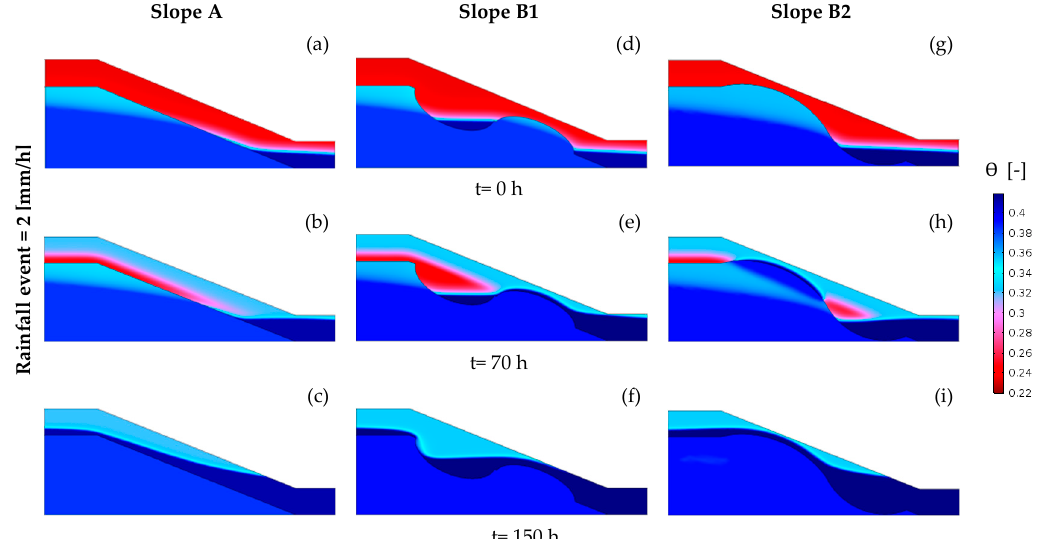
Figure 9. The temporal development of the soil water content distribution for a 150 h rainfall event with an intensity of 2 mm per hour for the 2D slope with a constant soil depth (slope A) at ( a ) t = 0 h, ( b ) t = 70 h, and ( c ) t = 150 h, and the 2D slopes with variable soil thickness (Slope B1 and B2) at ( d , g ) t = 0 h, ( e , h ) t = 70 h, and ( f , i ) t = 150